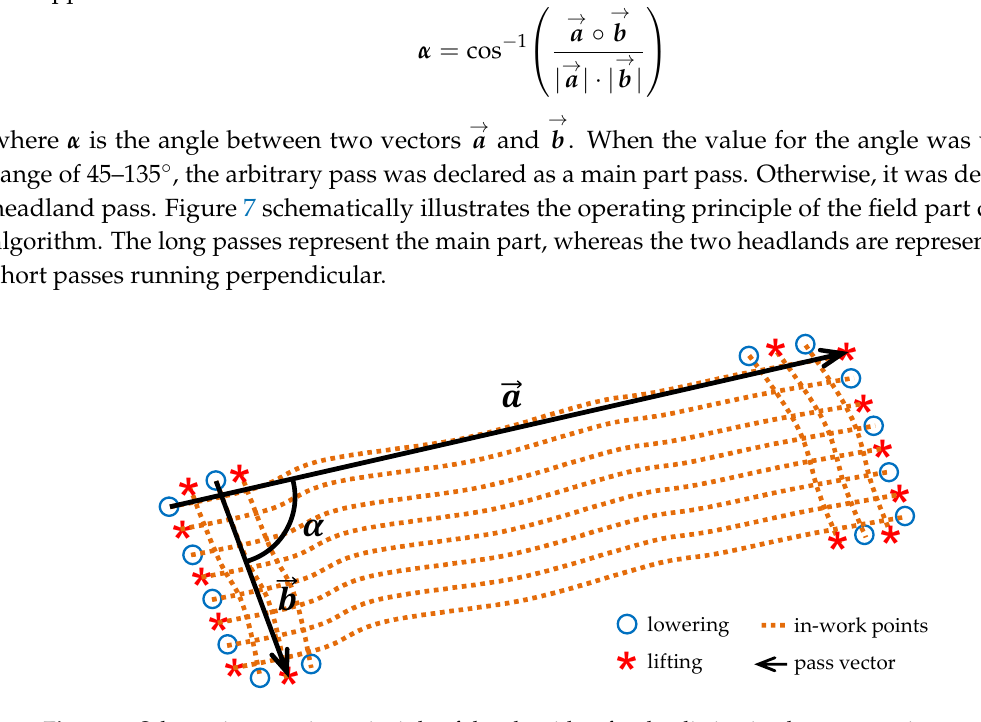
Figure 8. Relevant dimensions and schematic illustration for the modeling of the representative plow points for the two rotating positions of the plow: ( a ) rotated left; and ( b ) rotated right. For every rotating position separately, two points were defined that represented the lateral edges of the working width (points B and Γ). As can be seen in Figure 8a,b, the representative plow points are formed by first drawing a line parallel to the outer edge of the first and last share and crossing it with a perpendicular line, which is touching the front top of the shares. Then, this intersection point is projected vertically to the height of the antenna (Point A) to get the representative plow point. For the subsequent calculations, the left and right plow vectors pointing from the antenna to the